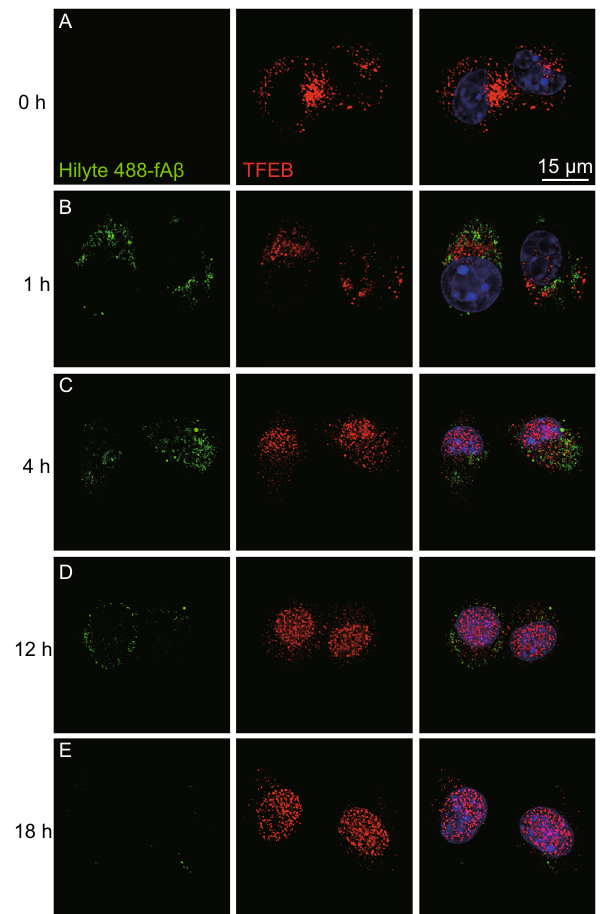
Figure 2. Fibrillar A β stimulates TFEB to translocate into nucleus. (A – E) TFEB translocates into nucleus under incubation of fi brillar A β . Confocal imaging of BV2 cells incubated with Hilyte488-labeled fA β (500 nmol/L, Green) at different time points and immunostained for endogenous TFEB (Red). Scale bar, 15 μ